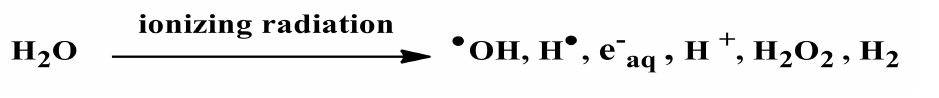
Figure 4. Primary process of radiolysis of water under irradiation. Source: Adapted Rosiak and Ulanski